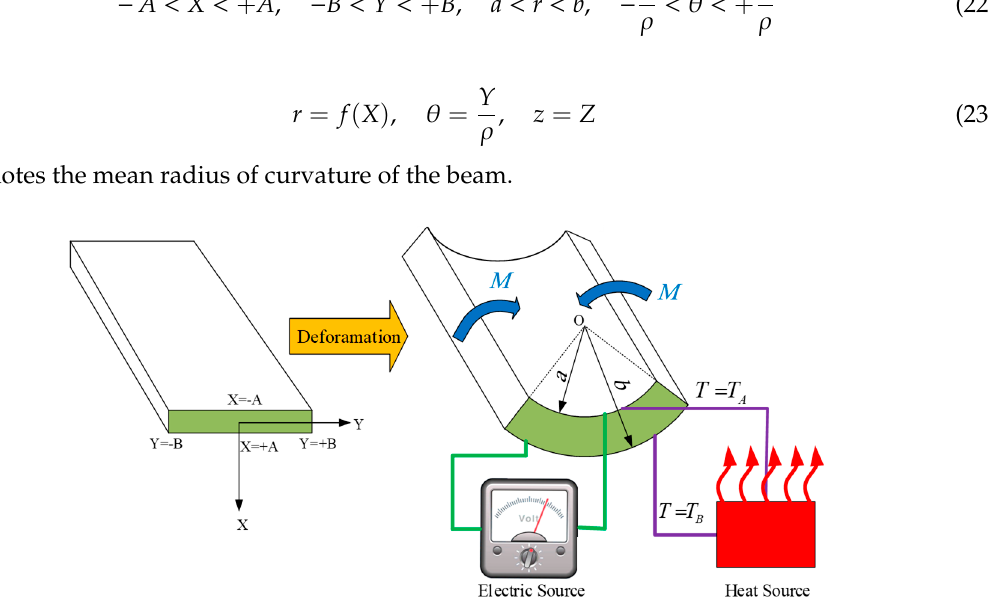
A schematic of plane-strain bending of a soft dielectric-based actuator under a thermo-electro-mechanical loading.